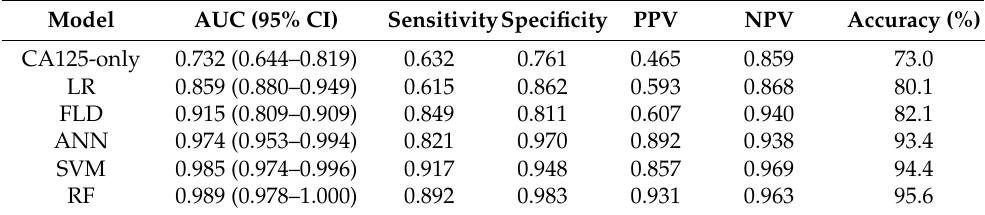
Table 2. Diagnostic efficacy of various supervised classification models for ovarian cancer. Model AUC (95% CI)